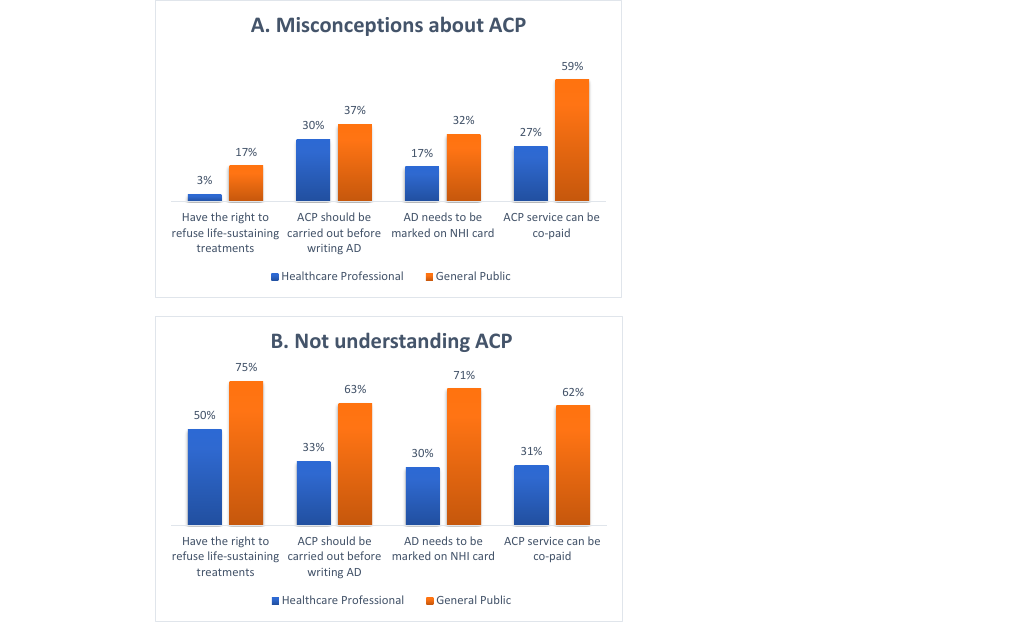
Figure 1. ( A ) Percentage of misconceptions of ACP between the general public and healthcare professionals. ( B ) Percentage of the general public and health professionals with misconceptions of ACP who think they do not understand ACP. (ACP: advance care planning; NHI: national health insurance; AD: advance directives).